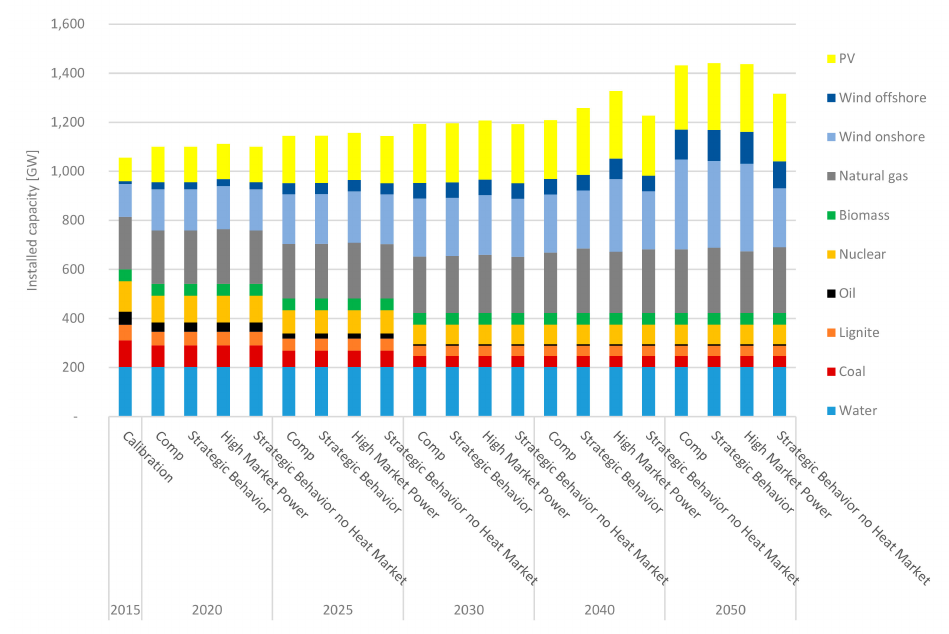
Figure 6. Developments of the endogenous and exogenous electrical